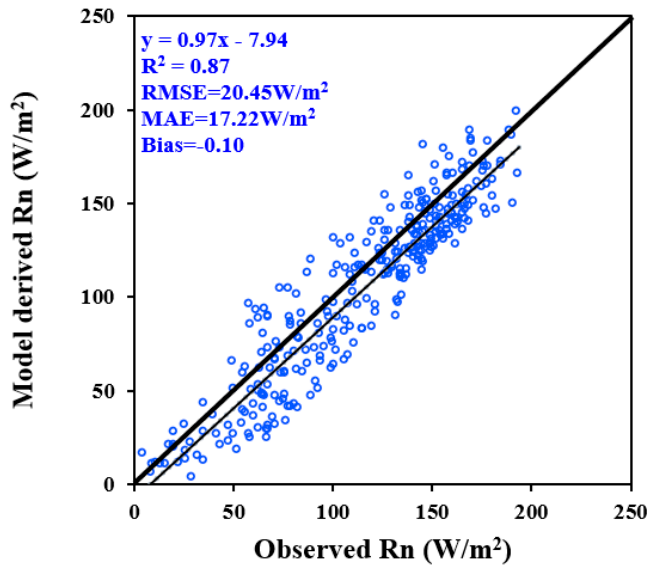
Figure 8. Scatters of the R n against in situ measurements, where R n : net radiation.